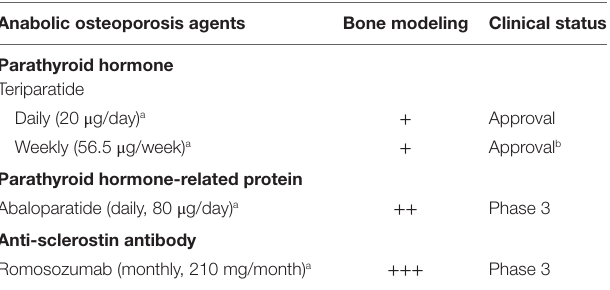
TABLE 1 | Expected effects of anabolic osteoporosis agents on bone